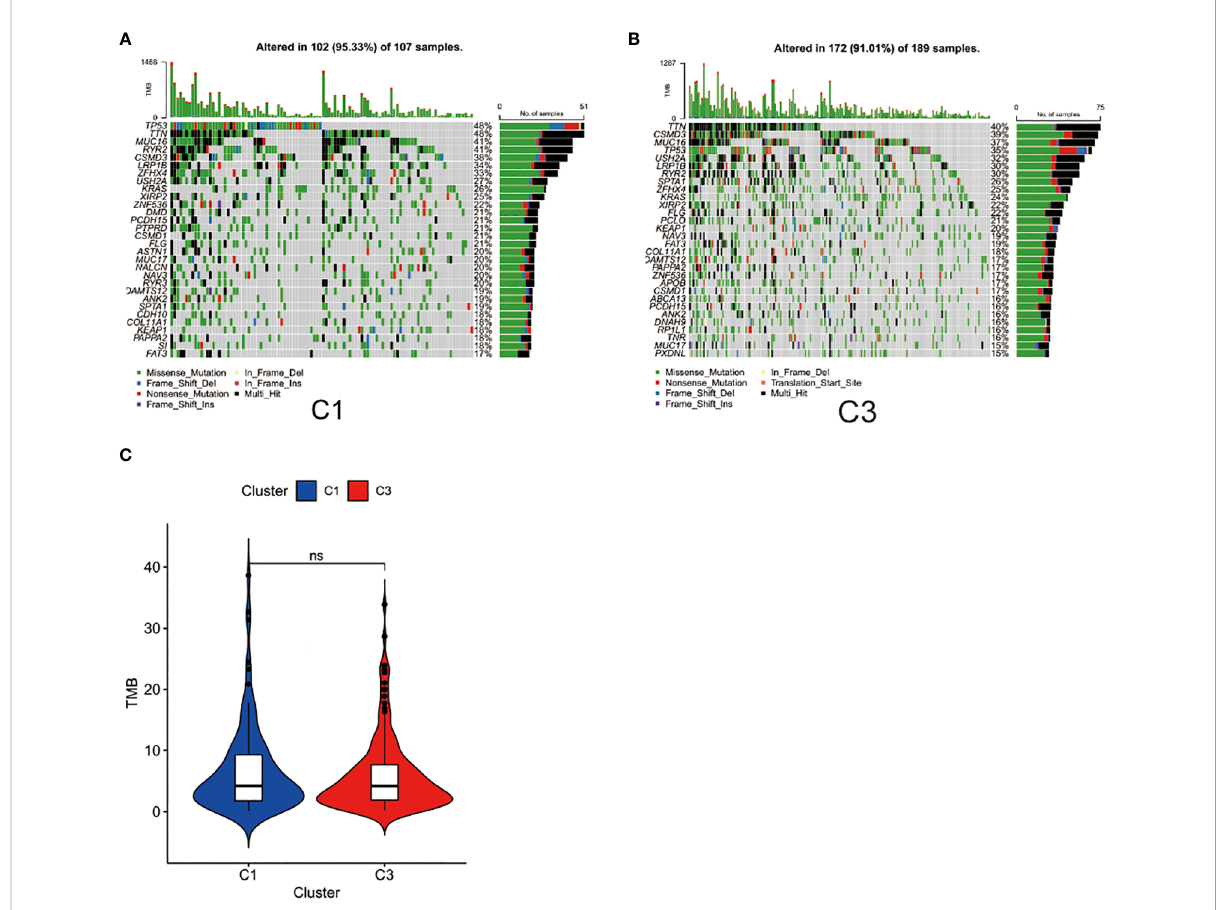
FIGURE 5 Gene mutational patterns of immune-based subtypes: Cluster 1 and Cluster 3. (A) Top 30 gene mutations in C1 subtype; (B) Top 30 gene mutations in C3; (C) Differences between the TMB scores of C1 and